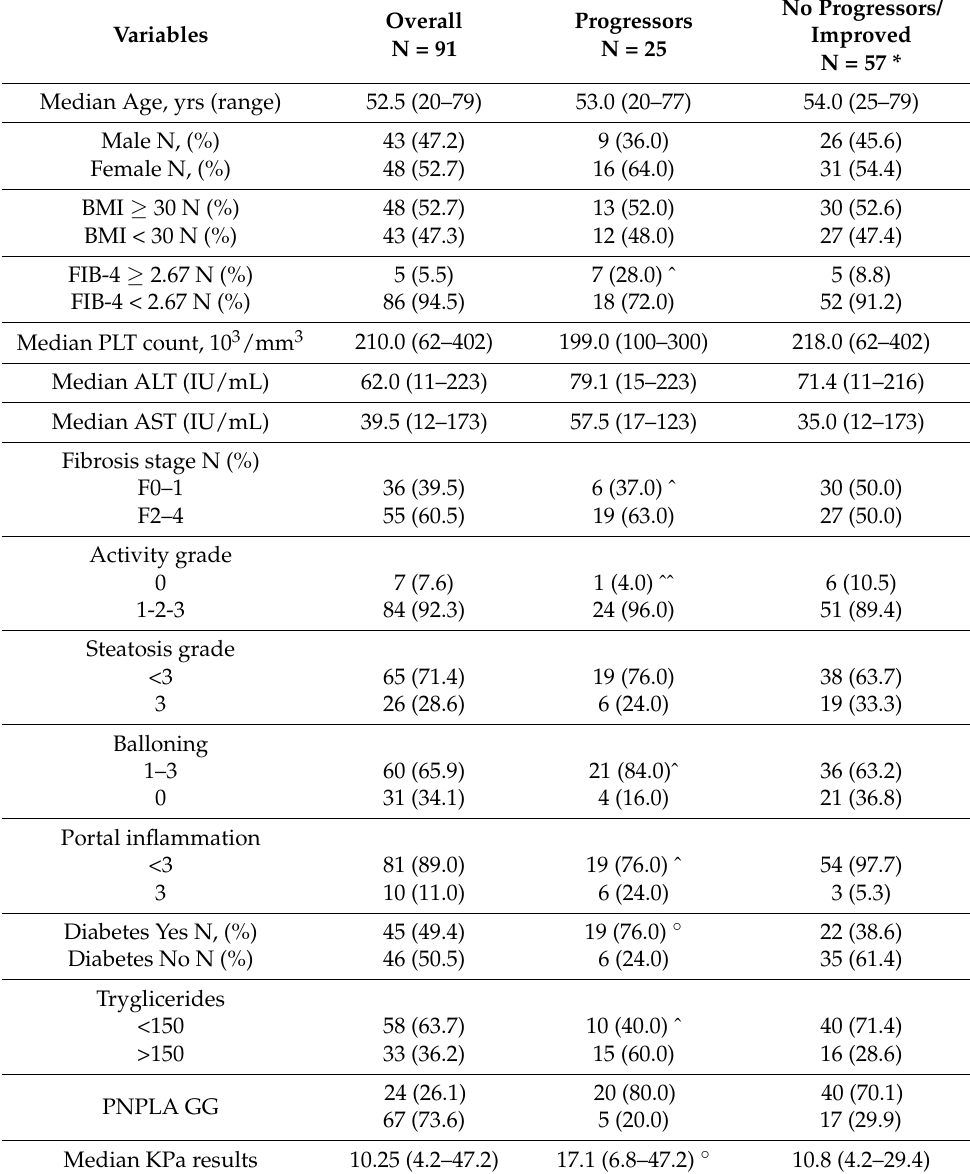
Table 1. Characteristics of patients overall, and by